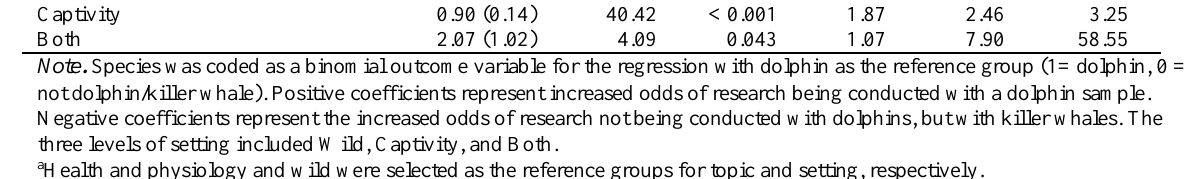
Logistic Regression Predicting Species by Topics and Setting Predictor Β (SE) Wald p Lower Odds Anthropogenic response -0.38